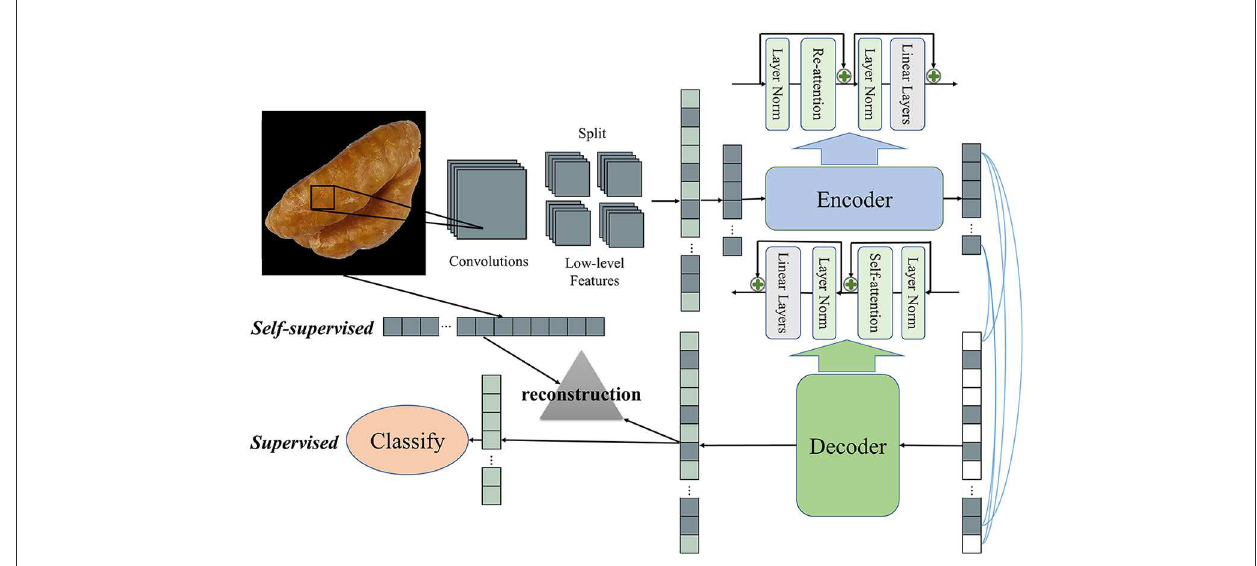
FIGURE3 The architecture of